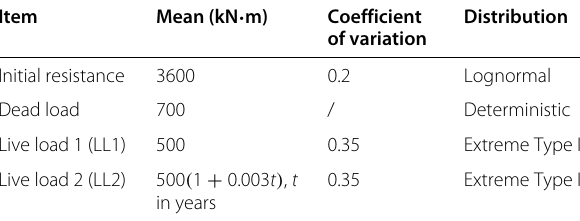
Table 1 Statistics of resistance and load effects of a single